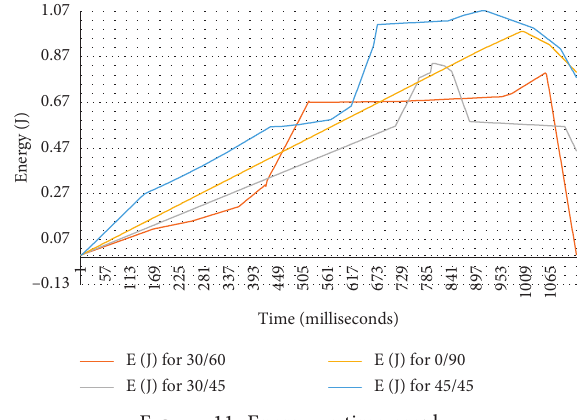
Figure 11: Energy vs time